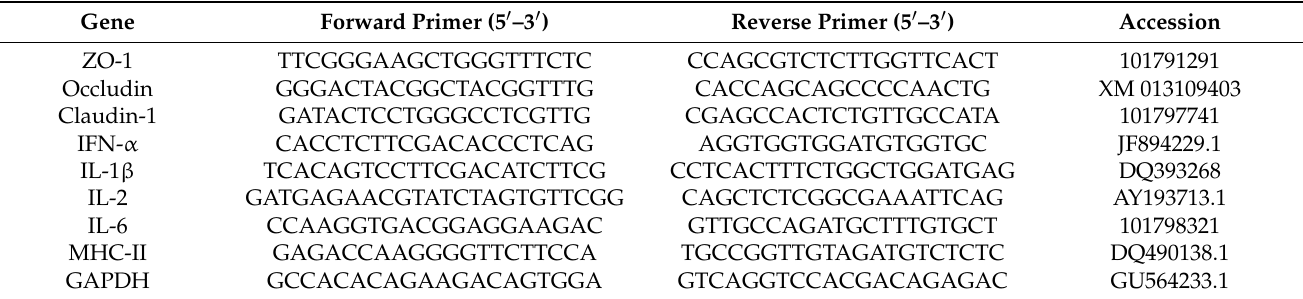
Table 1. Sequence of primers used in qRT-PCR to detect gene expression.